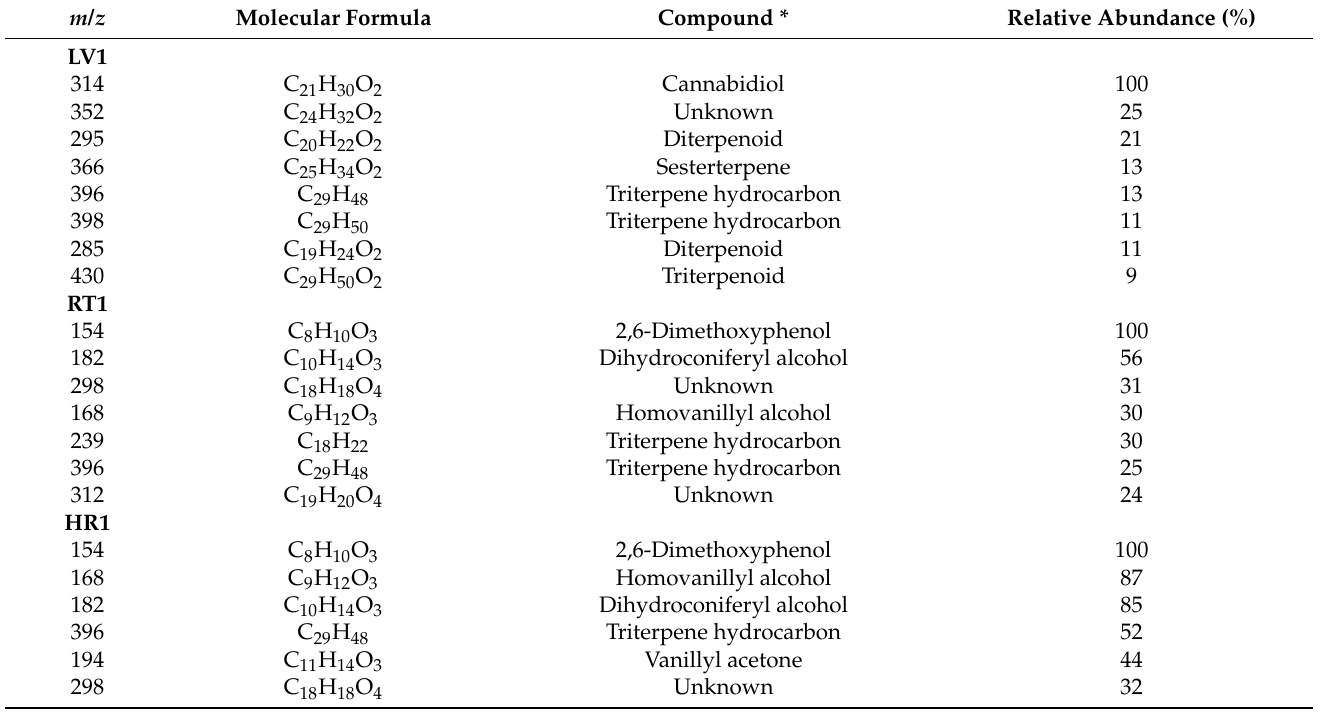
Table 11. Most abundant compounds detected in LV1, RT1, and HR1 with APPI FT-ICR MS. m / z Molecular Formula Compound